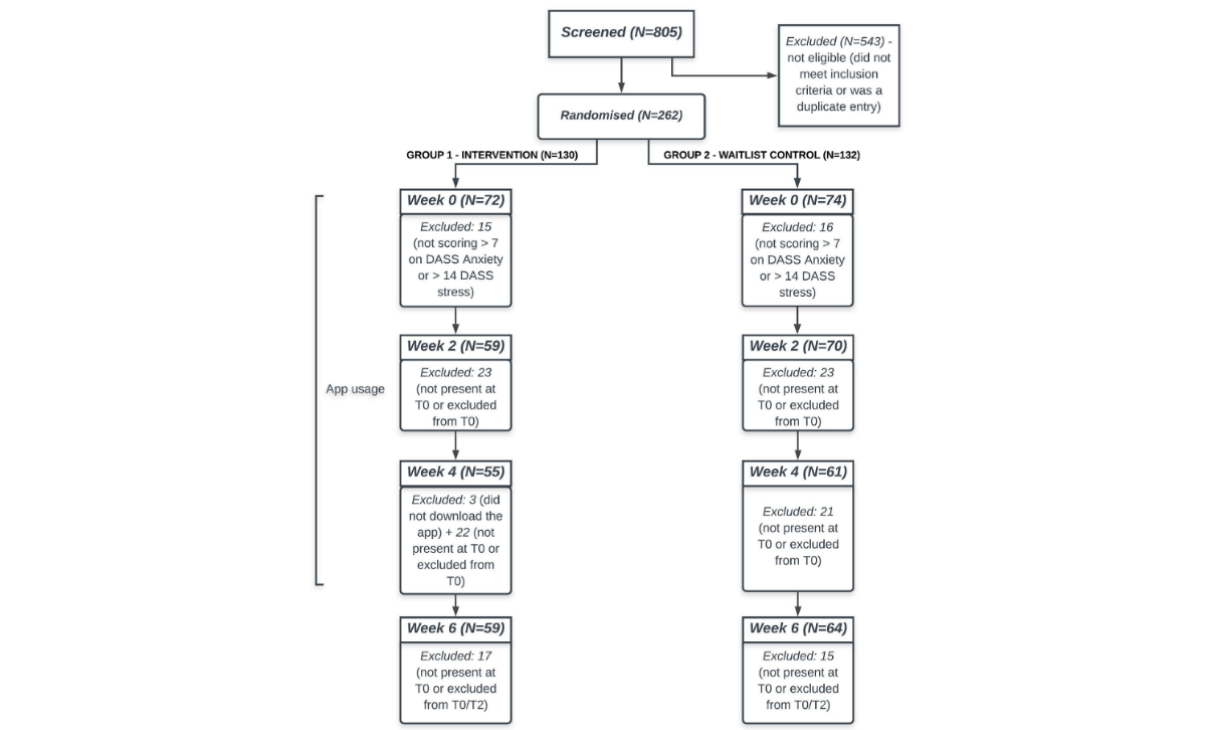
Figure 2. Flowchart of enrollment and retention rates throughout the study in the intervention and wait-list control groups.